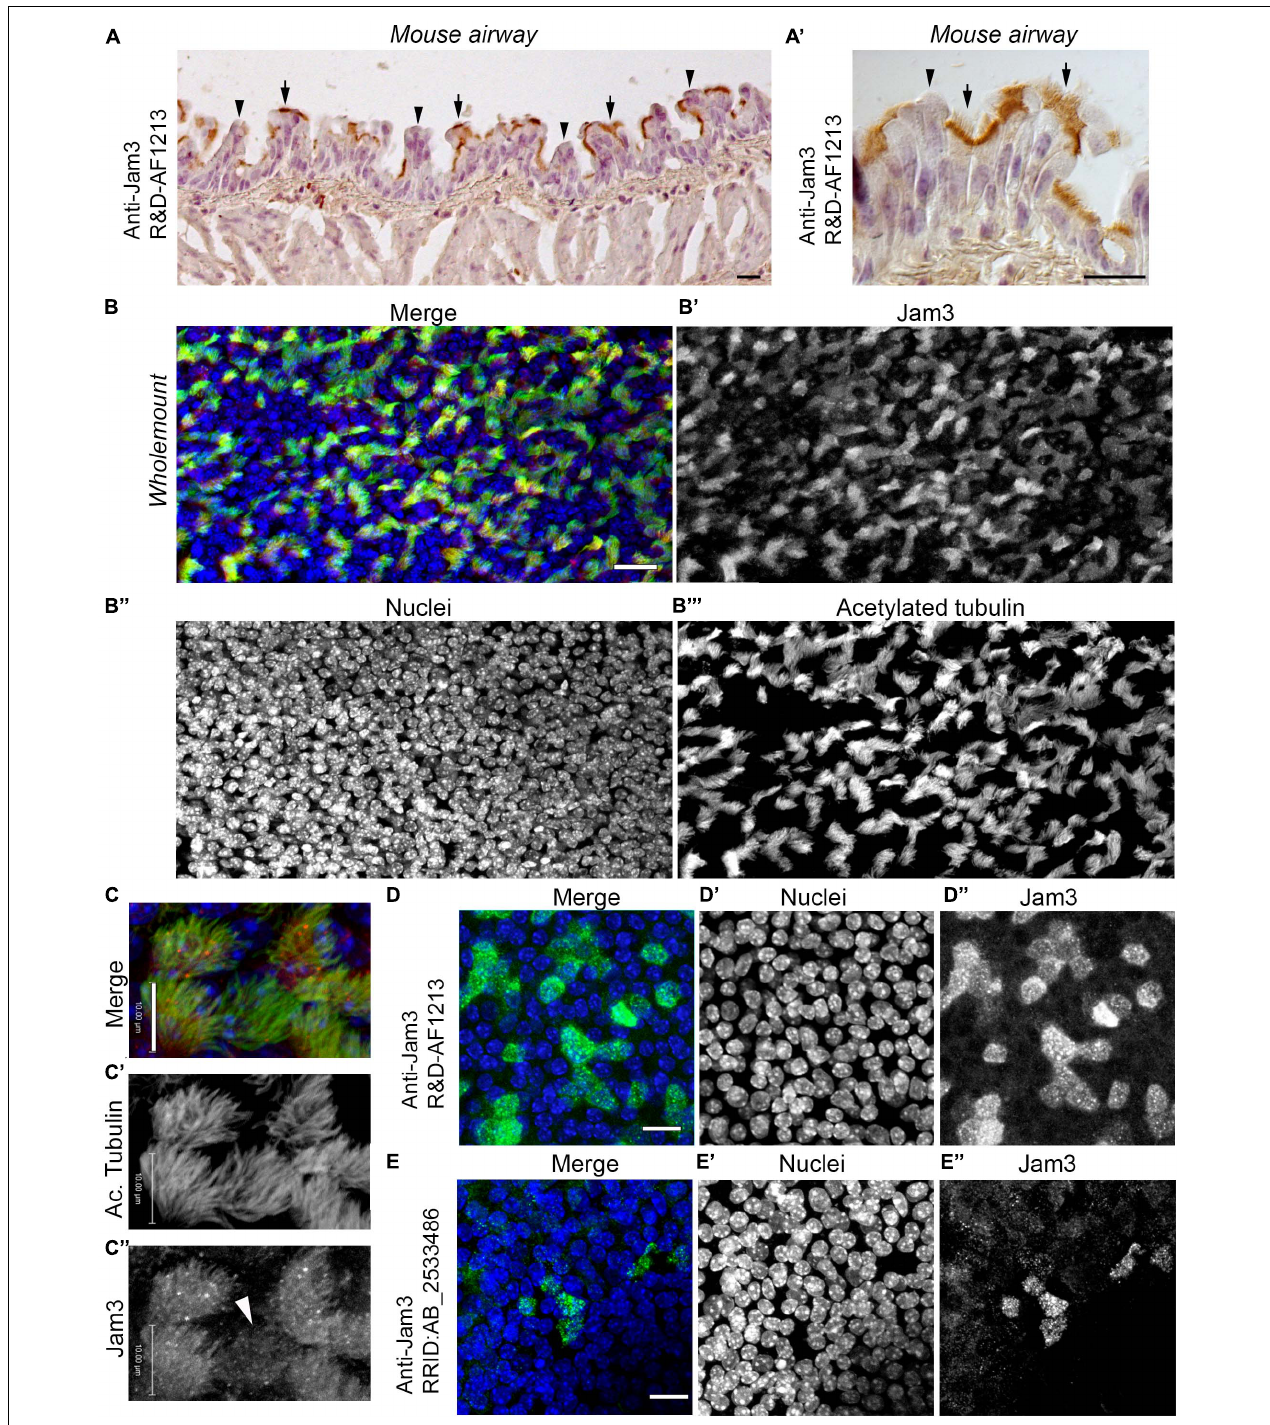
FIGURE 1 | Junctional adhesion molecule 3 (Jam3) is expressed in multiciliated cells in the mouse airway epithelium. (A) Immunohistochemistry of Jam3 in the mouse airway epithelium. Black arrows point to multiciliated cells, while black arrowheads point toward non-ciliated cells. (A’) A higher magnification image for a Jam3 immunohistochemistry in the mouse airway epithelium. (B’) A magnification of an immunohistochemistry image of Jam3 in the mouse airway epithelium. (B) Immunofluorescence in mouse whole-mount trachea for Jam3 in red (gray in panel B’ ), acetylated tubulin in green (gray in panel B’ ), and DAPI in blue (gray in panel B” ). (C) Confocal image with higher magnification for Jam3 localization in whole-mount tracheas, Jam3 in red (gray in panel C’ ), and acetylated tubulin in green (gray in panel C” ). (D,E) Jam3 immunofluorescence in MTECs differentiated for 14 days in vitro , nuclei in blue (gray in panels D’,E’ ), and Jam3 in green (gray in panels D’,E” ) using two different antibodies. Scale bar represents 10 µ m in panel (C) , represents 10 µ m, and represents 20 µ m in panels (D,E) . White arrowhead point a MCC with low Jam3 expression levels.